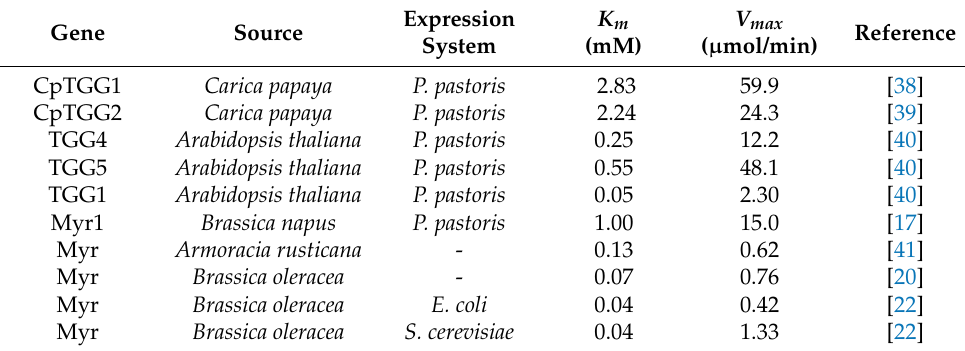
Table 2. Michaelis–Menten kinetic parameters of different β -thioglucosidases using sinigrin as